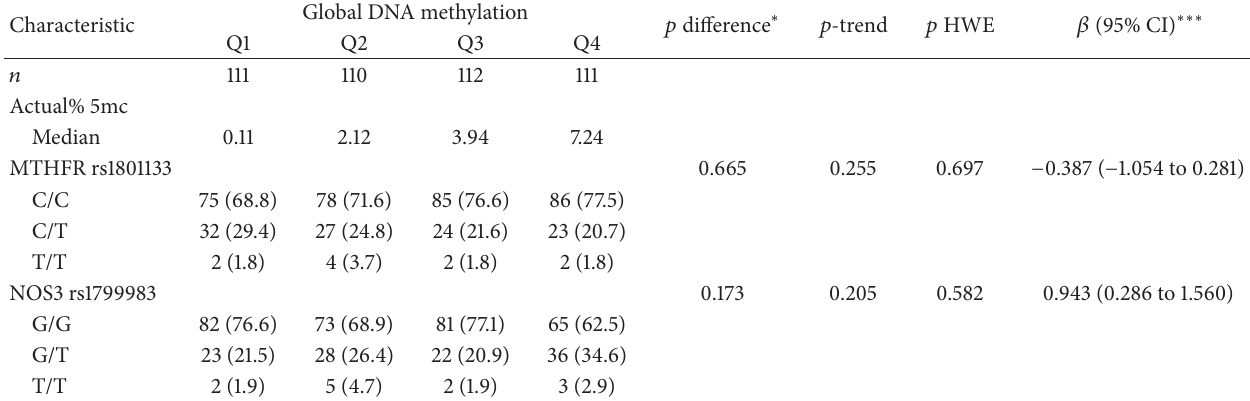
Table 3: Genotype distribution across the quarters of global DNA